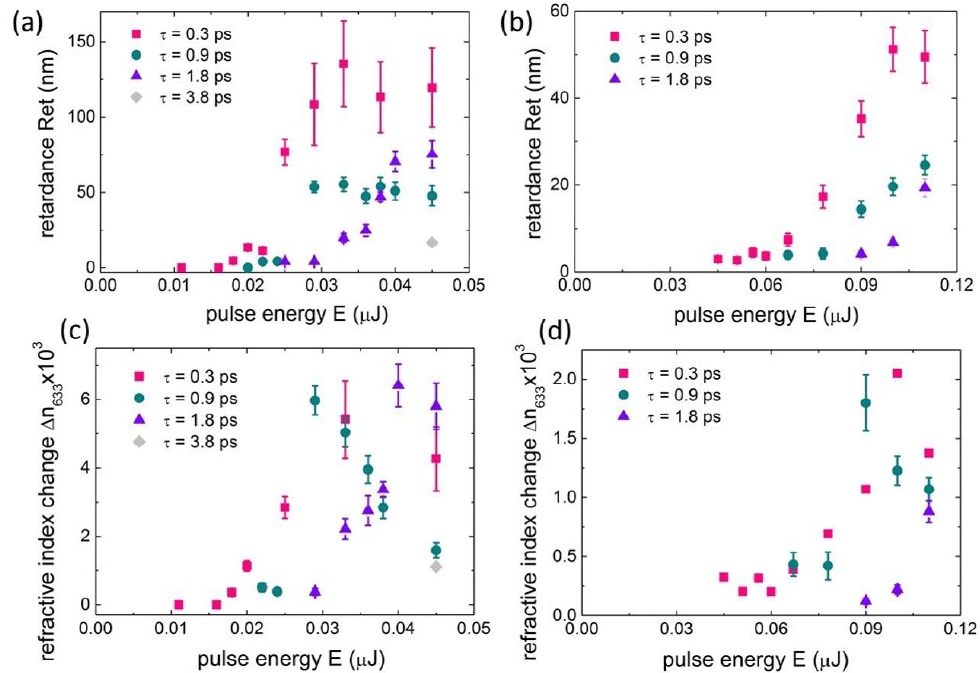
Figure 4. Background-corrected retardance Ret ( a , b ) and average refractive-index change Δ n 633 ( c , d ) versus pulse energy at different laser pulsewidths at 1030-nm ( a , c ) and 515-nm ( b , d ) wavelengths. In contrast, if the length L of the birefringent microtracks (Figure 3) is explicitly taken into account, the derivation for the first time average refractive index change, Δ n(633nm) = Ret / L , indicates very different dependence on laser pulsewidth τ (Figure 4c,d). Here, the maximal value of Δ n max ≈ (4 ± 2) 10 −3 at 1030 nm (Figure 4c) and Δ n max ≈ (1.5 ± 0.5) 10 −3 at 515 nm (Figure 4d) appear pulsewidth-independent but strongly wavelength-dependent, as expected according to the nanoplasmonic mechanism of the form-birefringence inscrip- tion in the form of bulk nanogratings [19,22]. Moreover, the maximal values are achieved in the threshold-like manner versus E (Figure 4c,d), as expected within the latter mecha- nism; they will be discussed below. Finally, such a refractive index change ( 10 −3 ) in the laser-modified np-FS could be related, in fused silica, to the increased mass density ( 1%), e.g., as a result of laser-induced nanoscale densification [26]. 3.3. Structural Modification Inside Microtracks The multi-shot microscale exposure of the np-FS sample by 1030-nm, 0.3-ps laser pulses induces the distinct compaction of the nanoporous material within the 3-line struc- tures and its rarefaction around them, as revealed by SEM and EDX (Figure 5a – c). The inscribed three-line segment exhibits the pronounced SEM contrast (Figure 5a) and the increased EDX intensity of O- and Si-components (Figure 5b,c) – by 6 rel. % and 2 rel. % (Figure 5d), respectively, relative to the surrounding non-modified material with its orig- inal 30% porosity. Such compaction in the segment is naturally accompanied by its pe- ripheral depleted regarding these chemical elements. Overall, the prolonged laser expo- sure apparently drives the nanoscale hydrodynamic phenomena of partial nanopore col- lapse in the laser-modified region and lateral material flow into it.